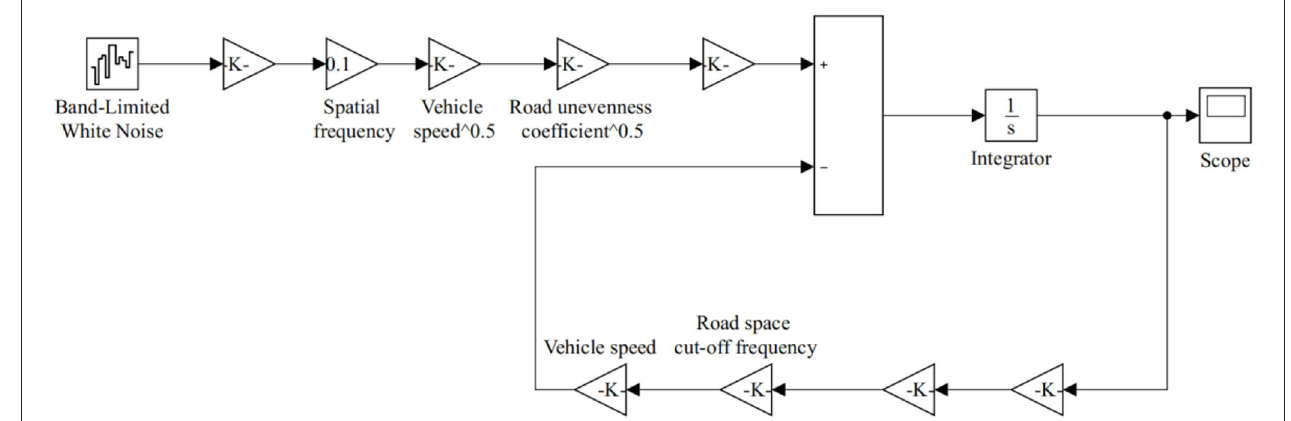
FIGURE 4 | Road excitation